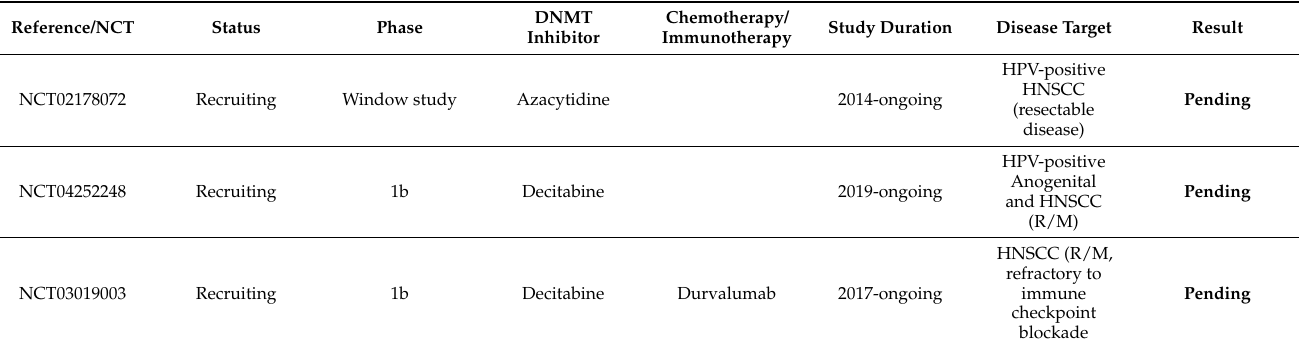
Table 1. Overview of clinical trials using DNMT inhibitors (monotherapy or combination) in